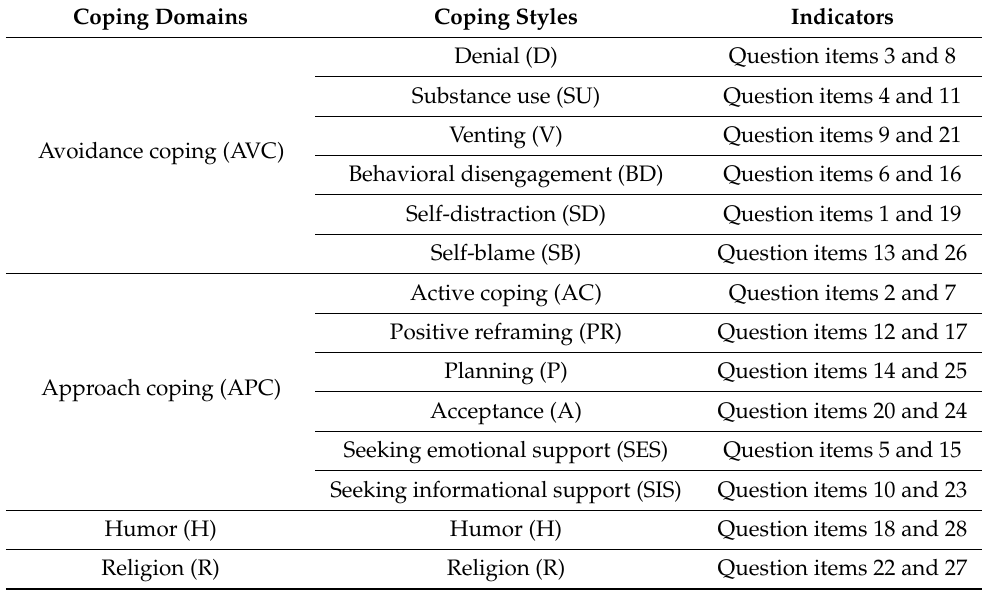
Table 1. Abbreviations for coping styles and